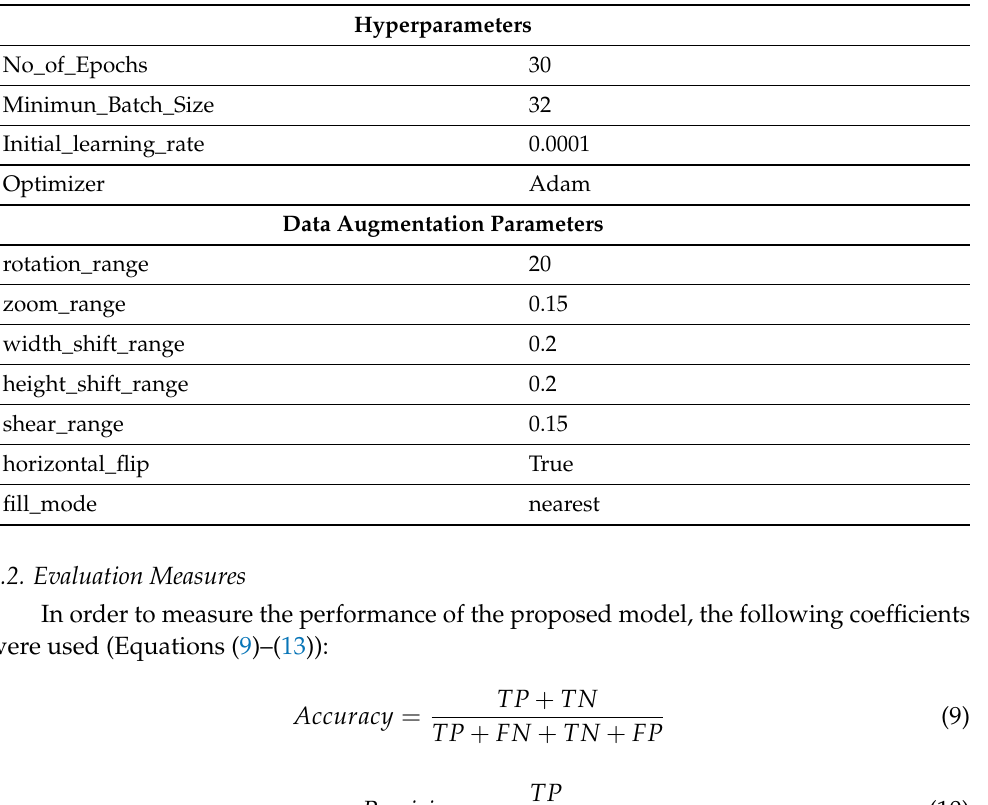
Table 2. Parameters used in the